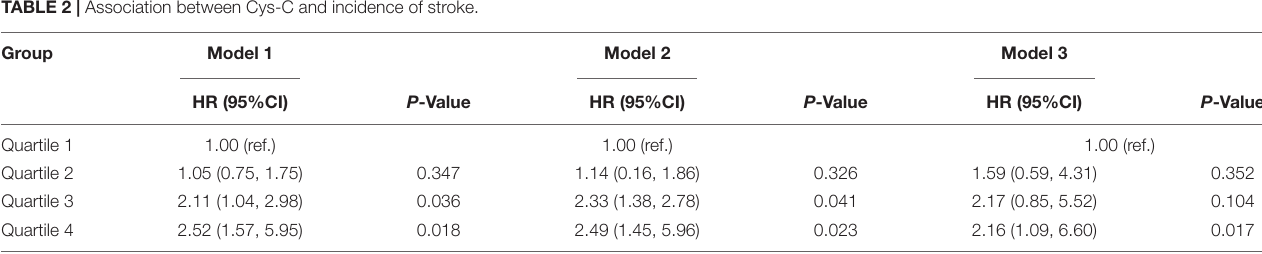
FIGURE 2 | Kaplan-Meier estimates of probability of cumulative incidence (%) for stroke. Log-rank test: P < 0.001; Quartile 1 was used as reference group. TABLE 2 | Association between Cys-C and incidence of